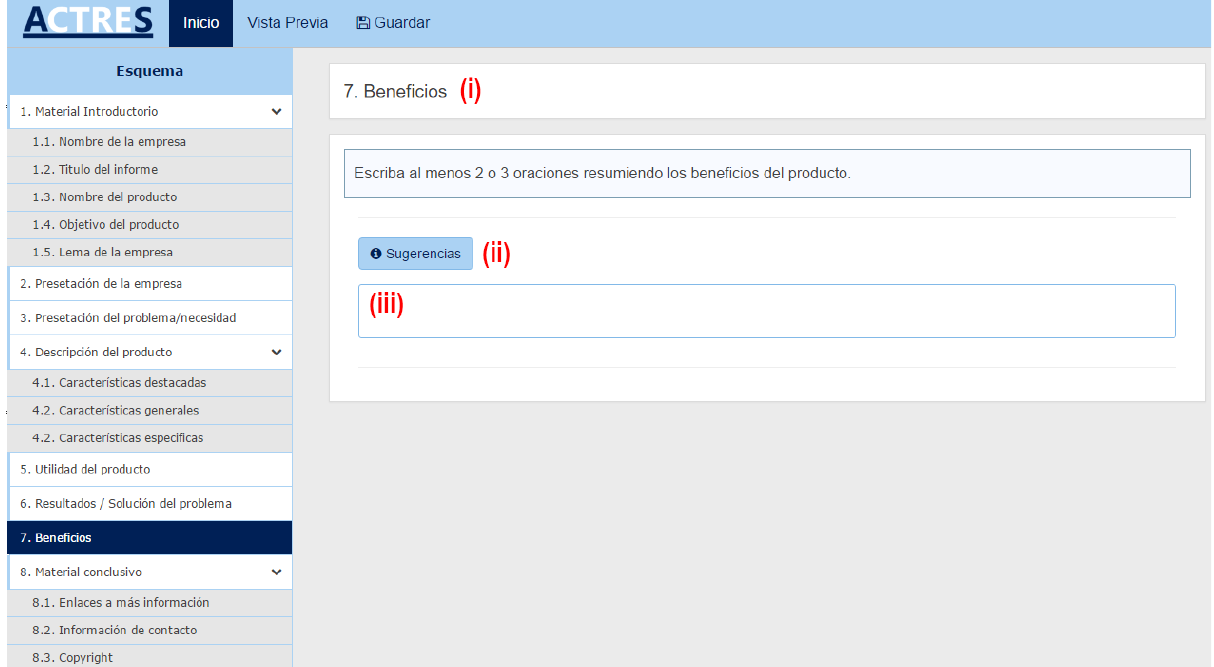
Figure 4. Drafting area of O-WEAA’s Writing Assistant Interface